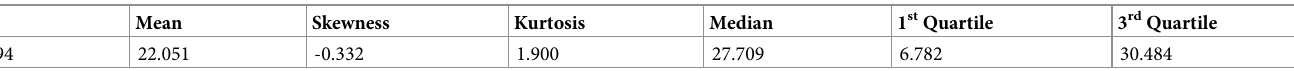
Table 3. Descriptive analysis.